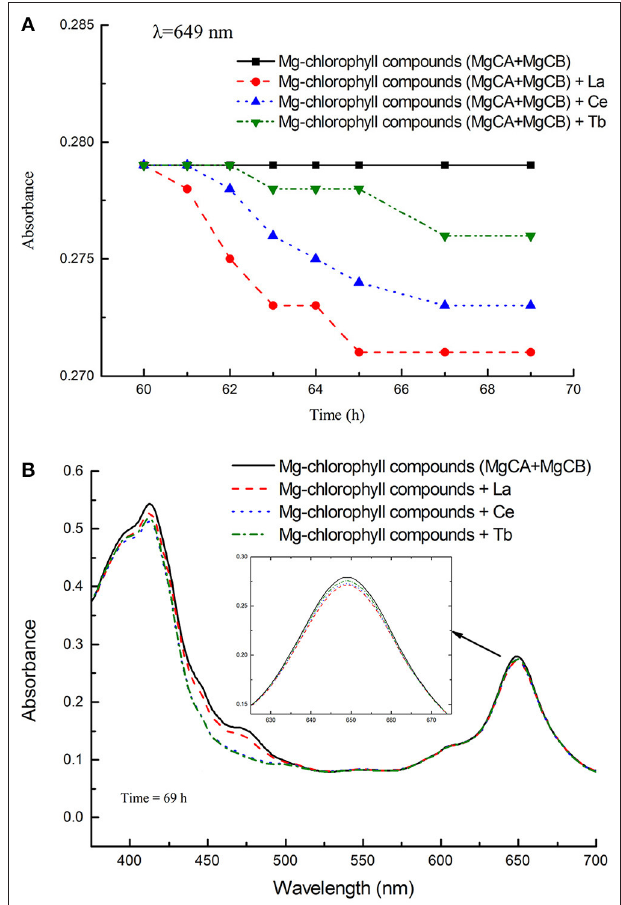
FIGURE 3 | The absorbance of different treatments in the in vitro experiments. (A) The absorbance of the blank control (MgCA + MgCB), La(NO 3 ) 3 + MgCA + MgCB, Ce(NO 3 ) 3 + MgCA + MgCB, and Tb(NO 3 ) 3 + MgCA + MgCB treatments as a function of reaction time, (B) UV-vis spectra of the control (MgCA + MgCB), La(NO 3 ) 3 + MgCA + MgCB, Ce(NO 3 ) 3 + MgCA + MgCB, and Tb(NO 3 ) 3 + MgCA + MgCB